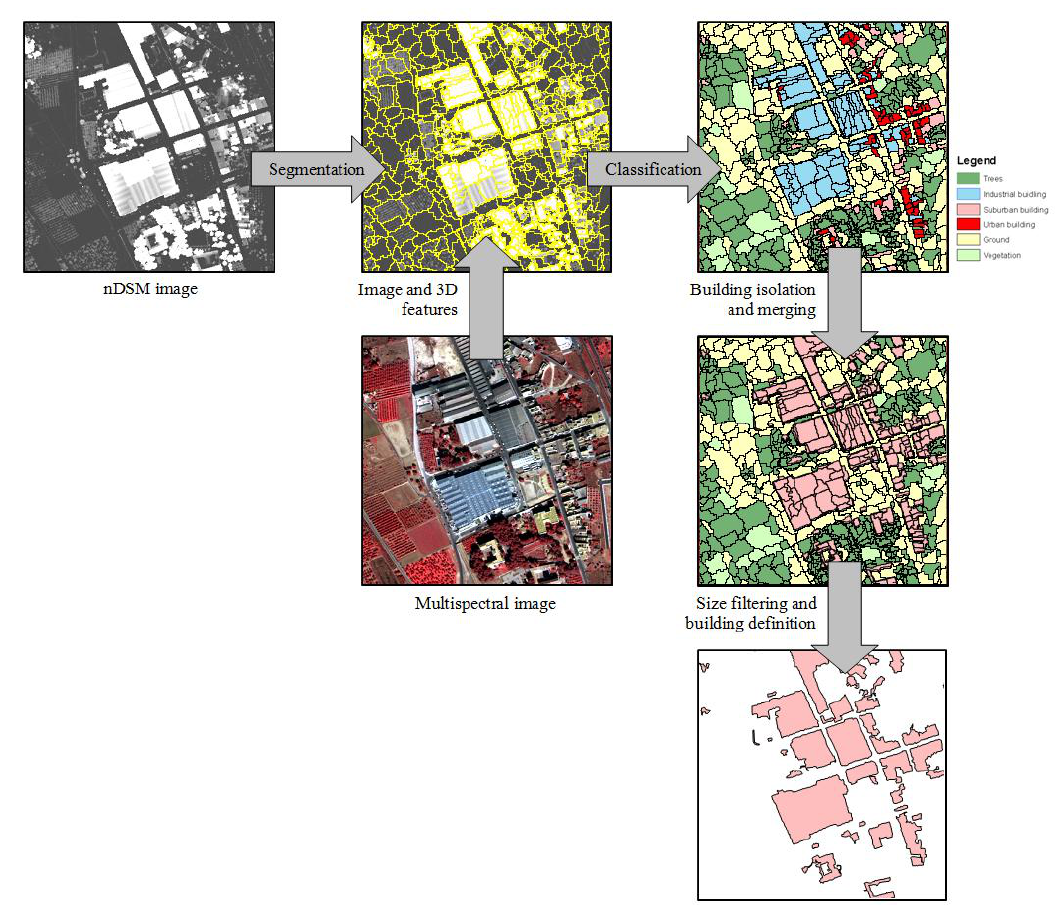
Figure 3. Scheme of the object-based classification building detection